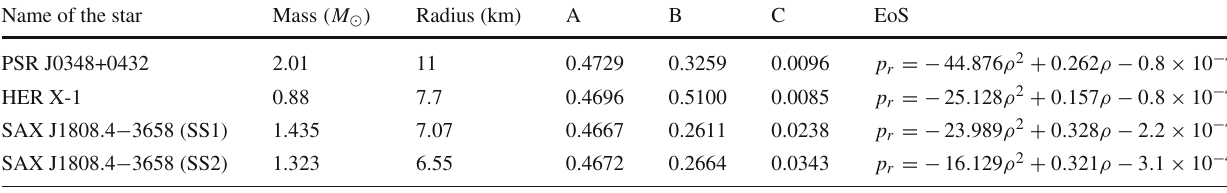
ering different β values with β 1 = 0. We have also deter- ( p r 0 ) and density at the boundary ( ρ b ) of the star. From the